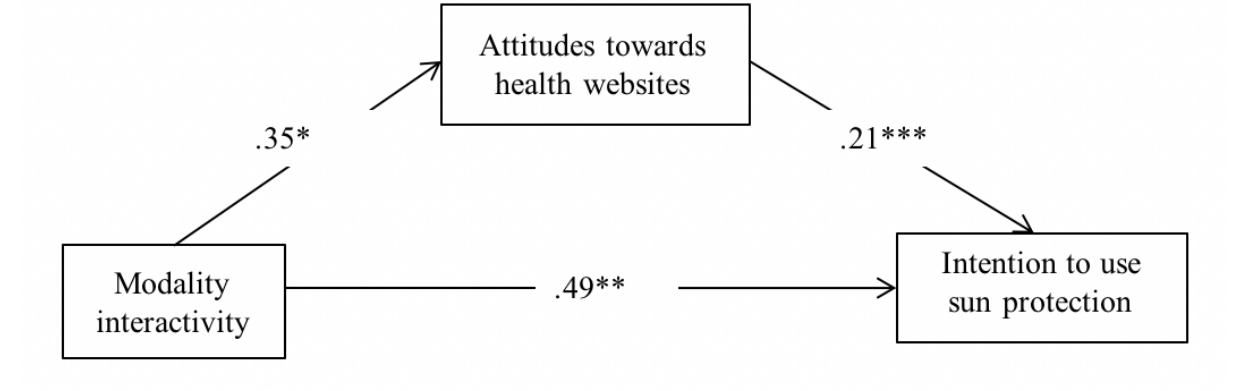
Figure 4. Mediation model of modality interactivity on intention through attitudes, including effects of control variables (age, sex, race, and education, which are not displayed). * P <.05; ** P <.01; *** P <.001.